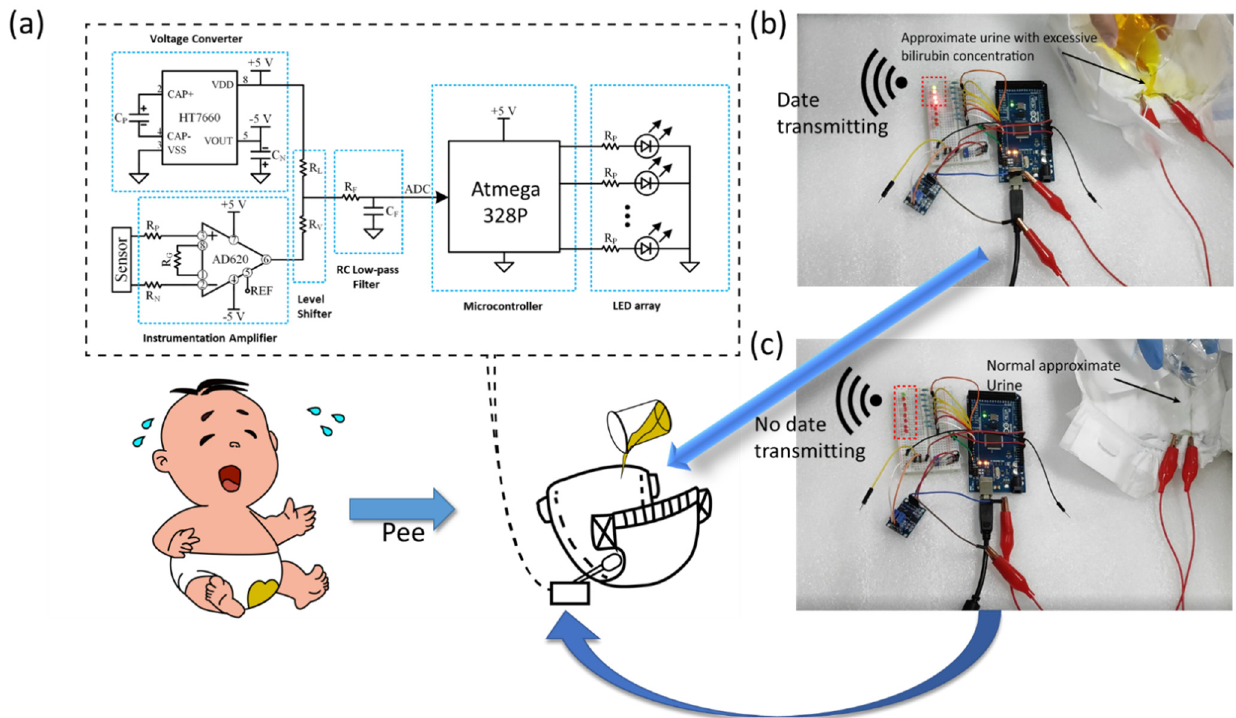
Figure 6. ( a ) Circuit diagram for sensing information transmission. ( b , c ) After dropping sodium bilirubin solution on the diaper, the concentration can be read out from the number of LED lights.